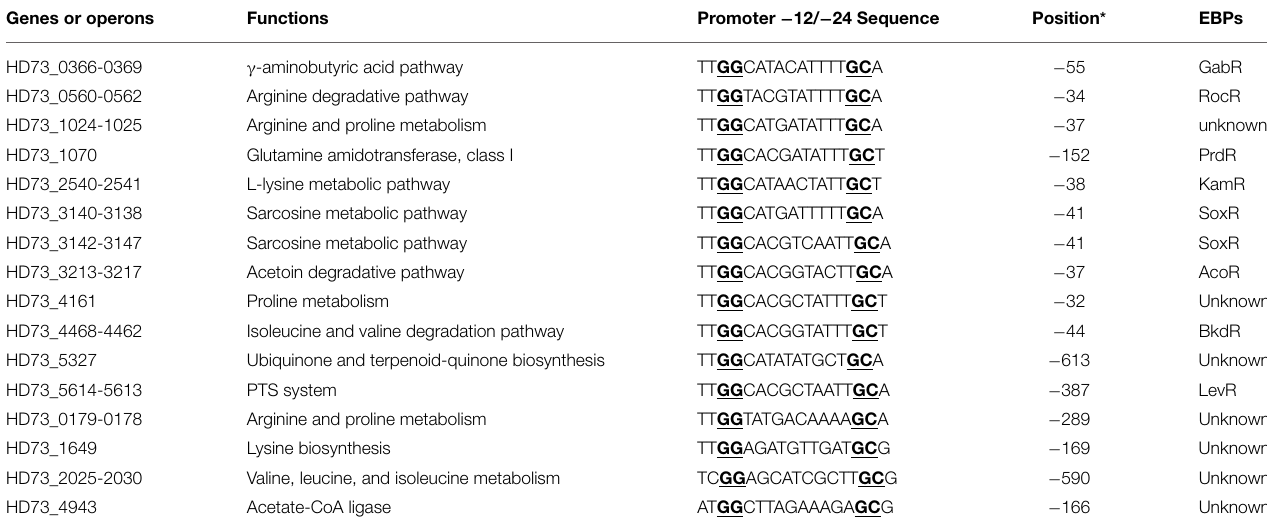
TABLE 2 | Genes or operons controlled by σ 54 in Bt. Genes or